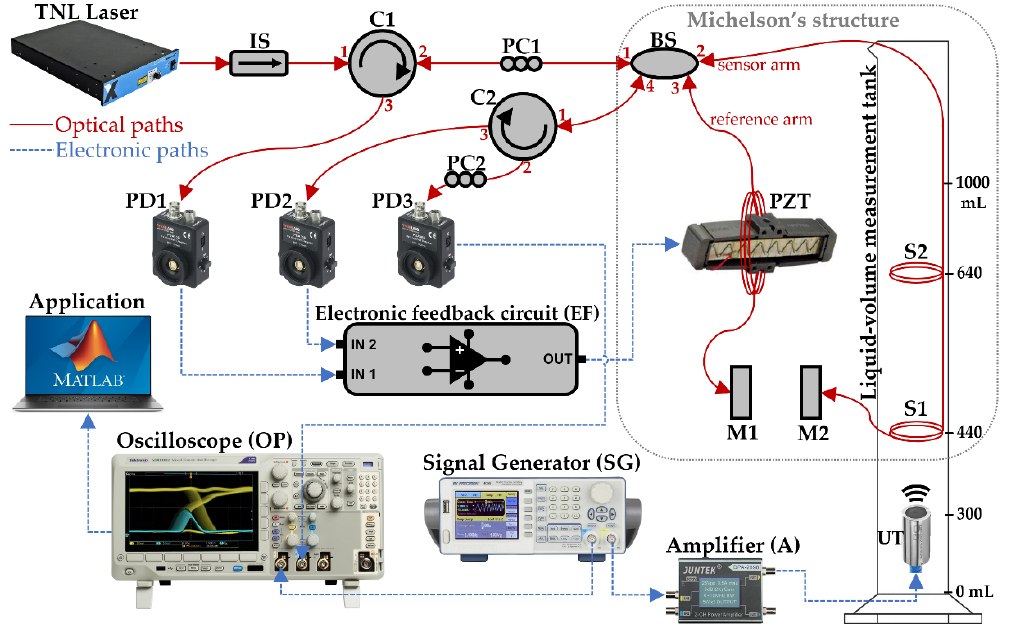
Figure 2. Fiber-optic hydrophone (FOH) system setup. TNL Laser at 1550 nm; IS—optical isolator; C1 and C2—optical circulators; BS—beam splitter; PC1 and PC2—polarization controllers; PD1, PD2 and PD3—photodetectors; M1 and M2—Faraday’s mirrors; PZT—piezoelectric actuator